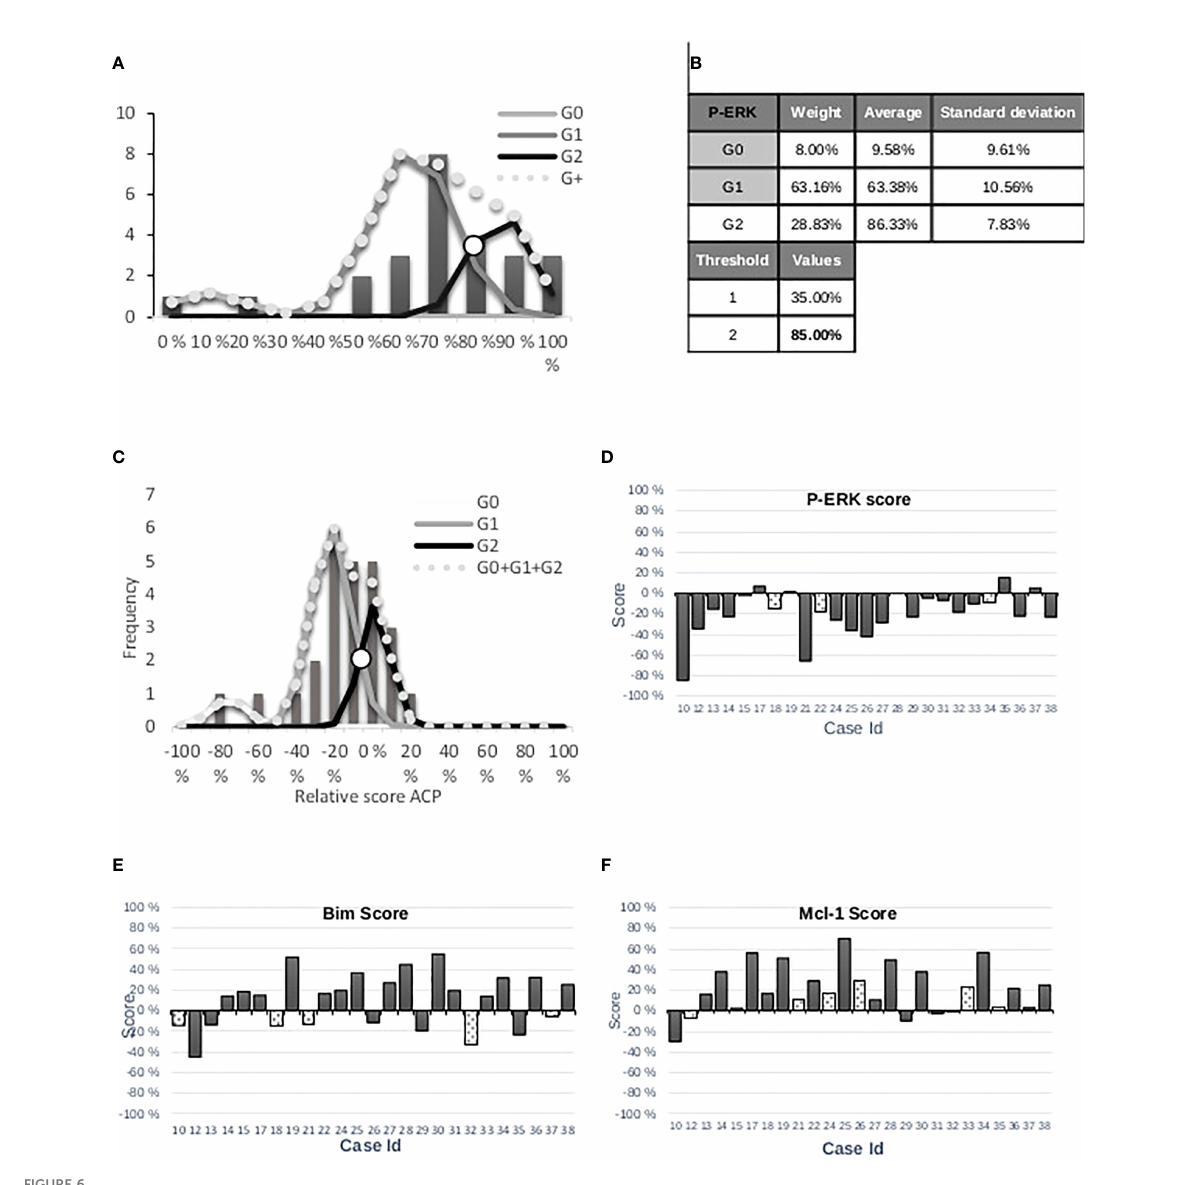
FIGURE 6 (A) Distribution of values of principal component 1 for P-ERK and three Gaussian functions. Automatic thresholds are determined with the algorithm of the Gaussian Mixture Model. (B) The threshold values correspond to crossing between Gaussians. (C) The highest threshold was selected and used as the 0-value. (D) Histogram representation of P-ERK marker score per patient by rapid reading. White bars corresponding to discordance between experts and IP. (E) Histogram representation of Bim marker score per patient. (F) Histogram representation of P-Mcl-1 marker score per